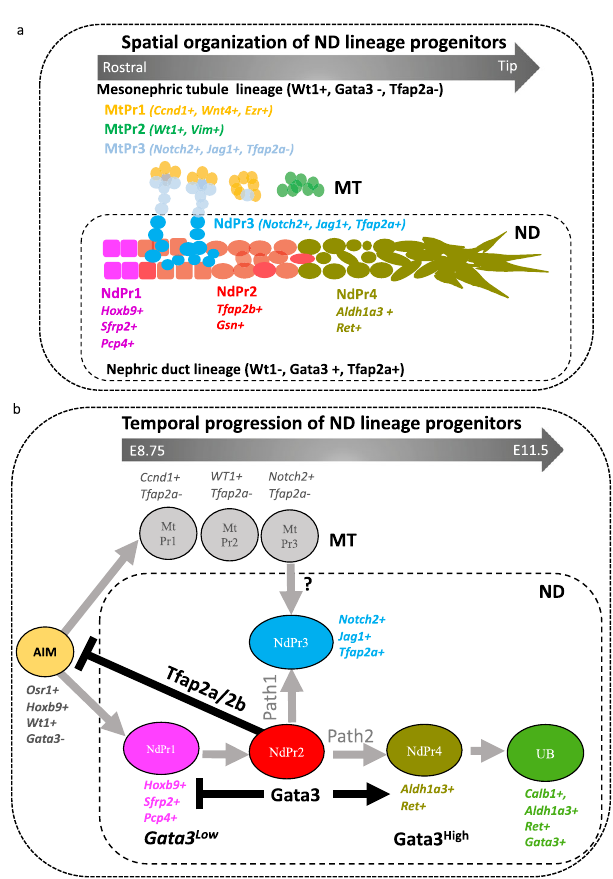
Fig. 7 Model for lineage progression during nephric duct development. Schematic representation of the spatial ( a ) and temporal ( b ) hierarchy of nephric duct (ND) progenitor cells. NdPr: nephric duct progenitor, MT: mesonephric tubules, MtPr: mesonephric tubule progenitor, AIM: anterior intermediate mesoderm, UB: ureteric extracted genomic DNA using primers listed in Supplementary Table 1 followed by Sanger Sequencing and Illumina Miseq PE300 sequencing. Targeting ef fi ciency and analysis of indels was assessed with the web tools Tracking of Indels by Decom- position, Inference of CRISPR Edits (ICE) and Cas-Analyzer and Integrative Genomics Viewer 80 – 82 . Single cell and cluster RNA-seq Isolation of single cells and cell clusters from the trunk of mouse embryos . Control (E8.75, E9.0 and E9.5 Pax2-GFP; E9.5 Pax2-GFP;Gata3 + / − ; E11.5 C57Bl/6 ) and